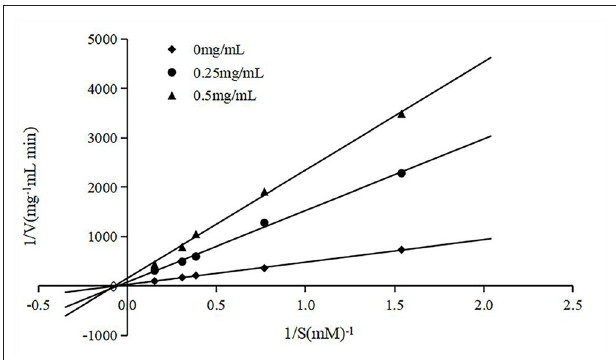
FIGURE 3 | Lineweaver-Burk plots of ACE inhibition by F3.